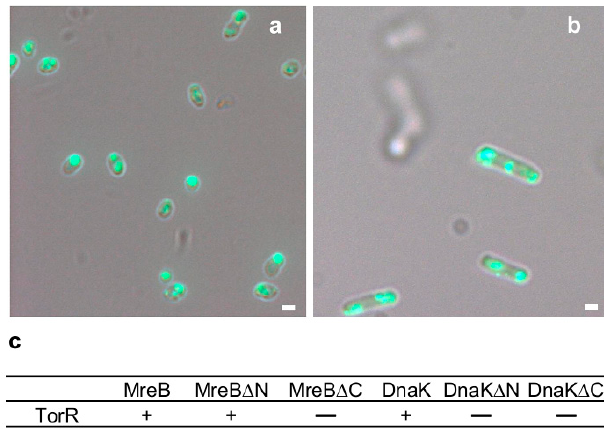
Figure 4. The MreB and DnaK proteins interact with TorR and are required for localization of TorR-GFP at the old poles of cells. ( a ) Exponentially growing W3110 ∆ torR /pTorR-GFP cells in ABTGcasa with IPTG at 37 ◦ C were treated with A22 (10 µ g/mL) for 6 h to inhibit MreB, and then fixed in 70% ethanol. The subcellular localization of TorR-GFP was visualized by fluorescence microscopy. The scale bar represents 1 µ m; ( b ) Growth condition and TorR-GFP visualization in exponentially growing W3110 ∆ dnaK /pTorR-GFP cells were as described in the legend to ( a ). The scale bar represents 1 µ m; ( c ) BTH101 cells were co-transformed with a mixture of pKNT- torR and pUT- mreB plasmids for testing TorR-MreB interaction, pKNT- torR and pUT- dnaK for TorR-DnaK, pKNT- torR and pUT- mreB ∆ 2-90 for TorR-MreB ∆ N, pKNT- torR and pUT- mreB ∆ 180-281 for TorR-MreB ∆ C, pKNT- torR and pUT- dnaK ∆ 1-100 for TorR-DnaK ∆ N, or pKNT- torR and pUT- dnaK ∆ 510-639 for TorR-DnaK ∆ C interaction, plated on LB agar plates containing X-gal, IPTG, and required antibiotics, incubated at 30 ◦ C for 30 h. + stands for protein–protein interaction as shown (blue colonies) in Figure S7—presents no protein–protein interaction as indicated (white